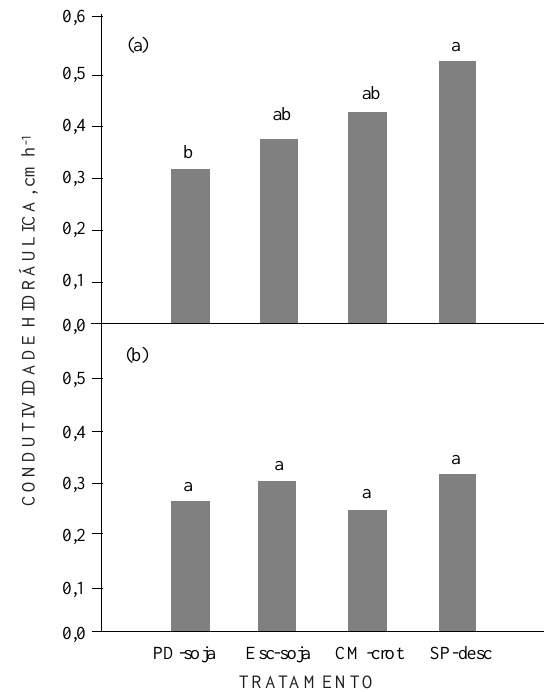
Figura 4. Condutividade hidráulica em solo não saturado (K ) na superfície (a) e a 0,12 m de ( qqqqq ) profundidade (b) sob diferentes sistemas de manejo. Médias seguidas de mesma letra não diferem estatisticamente entre si pelo teste DMS a 5 % de